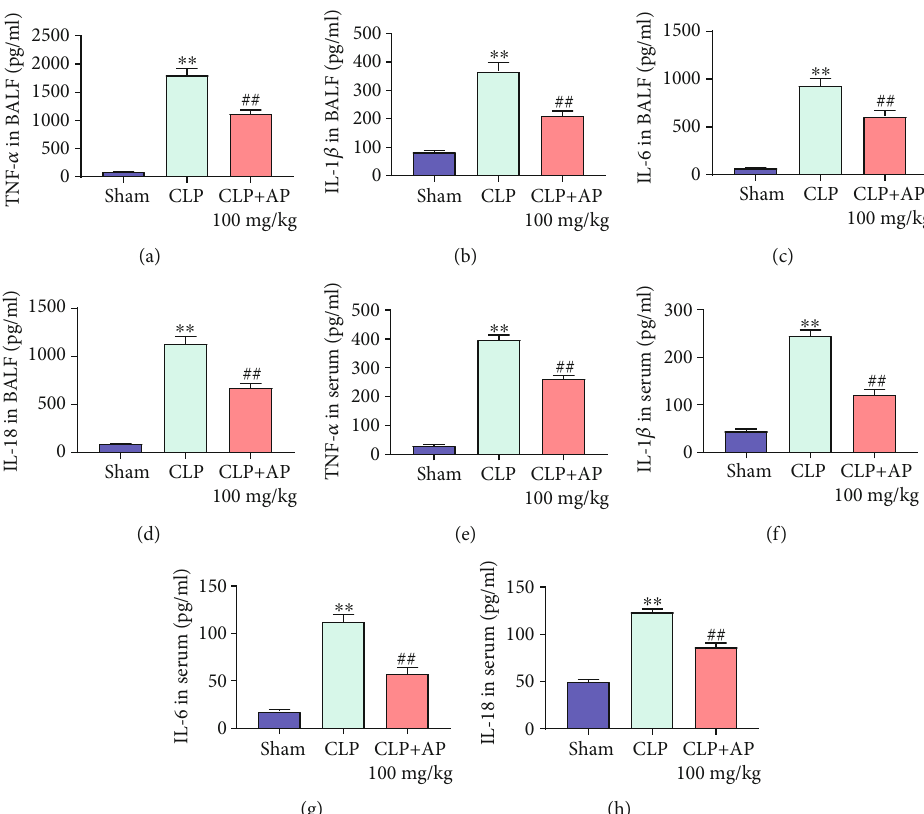
Figure 3: AP inhibited the production of in fl ammatory cytokines in both the BALF and serum of sepsis-induced ALI mice. The levels of TNF- α (a), IL-1 β (b), IL-6 (c), and IL-18 (d) in BALF were measured by ELISA. The levels of TNF- α (e), IL-1 β (f), IL-6 (g), and IL-18 (h) in serum were measured by ELISA. ∗∗ P < 0 : 01 , vs. Sham group; ## P < 0 : 01 , vs. CLP